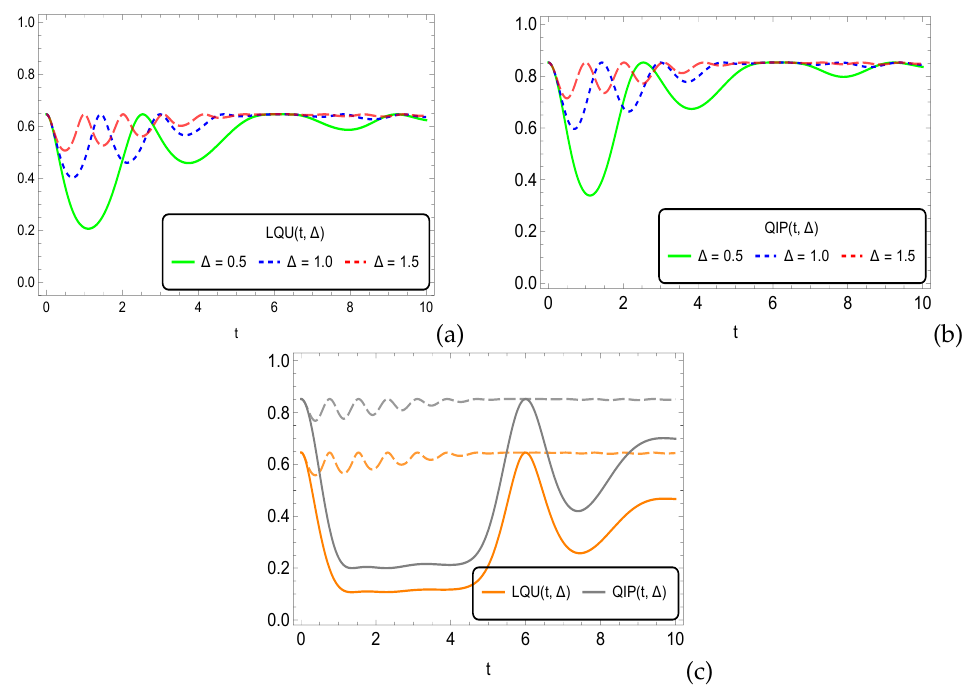
Figure 3. LQU and QIP as a function of time versus different values of ∆ . LQU ( a ) and QIP ( b ). Graph ( c ): ∆ = 0.1 (solid lines) and ∆ = 2.0 (dashed lines). For all plots r = 0.9, ω = π /6, and b = 0.5.